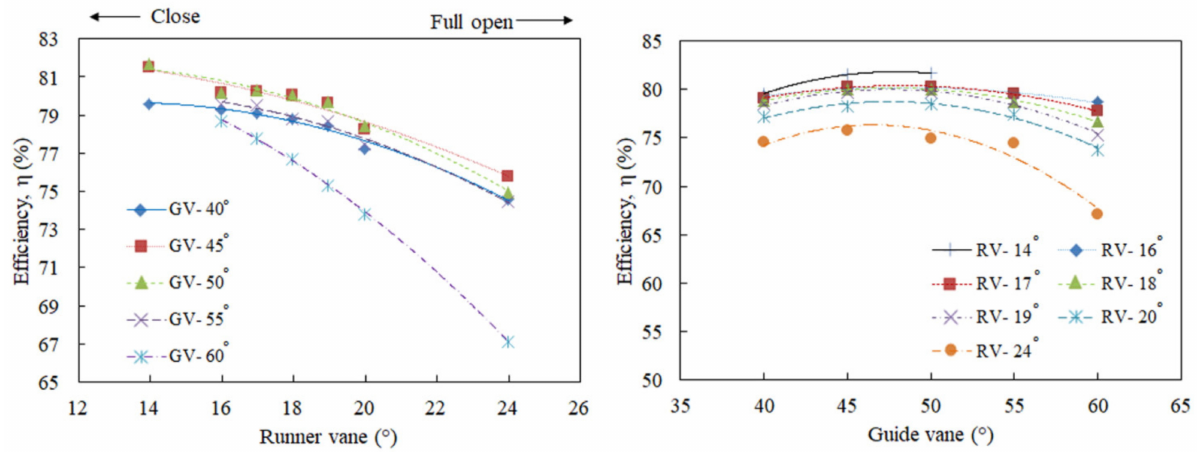
Figure 13. Efficiency changes according to runner vane and guide vane opening